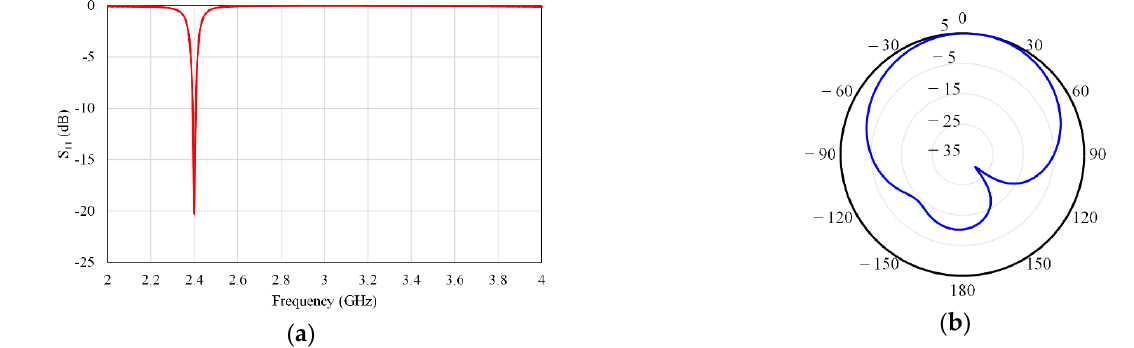
Figure 8. ( a ) The simulated results of the proposed antenna with RT-Duroid 5880 substrate at 2.4 GHz ( a ) S 11 response and ( b ) 2D radiation pattern.